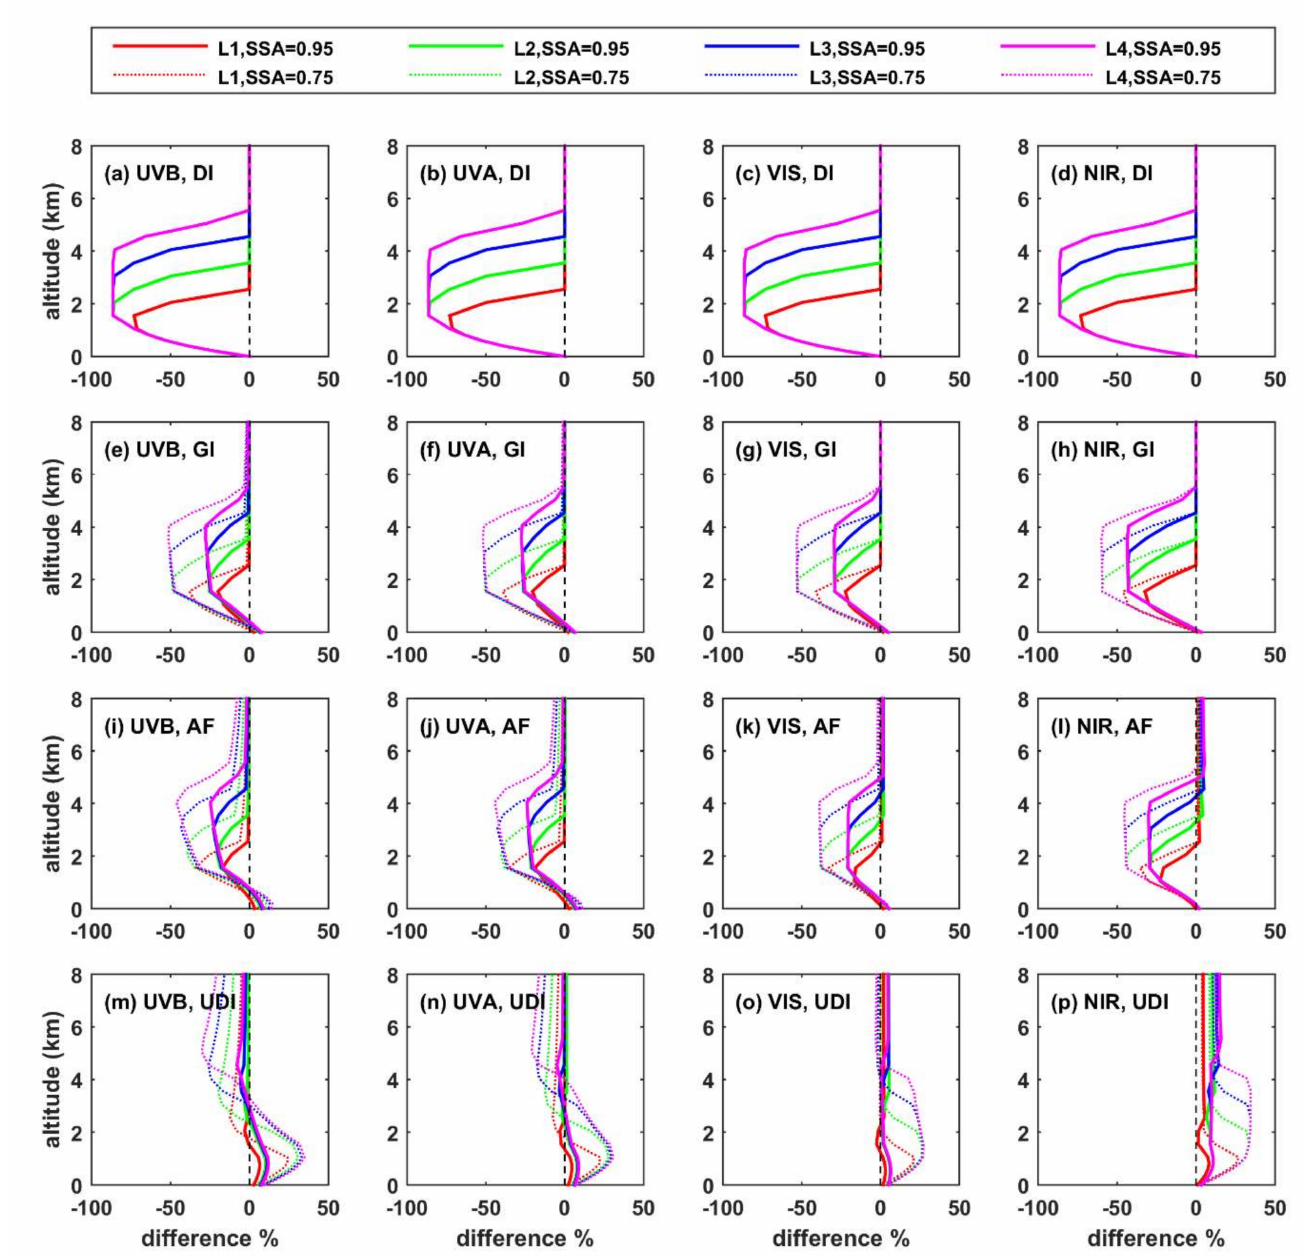
Figure A5. Same as Figure 3, but for surface albedo = 0.8 instead of